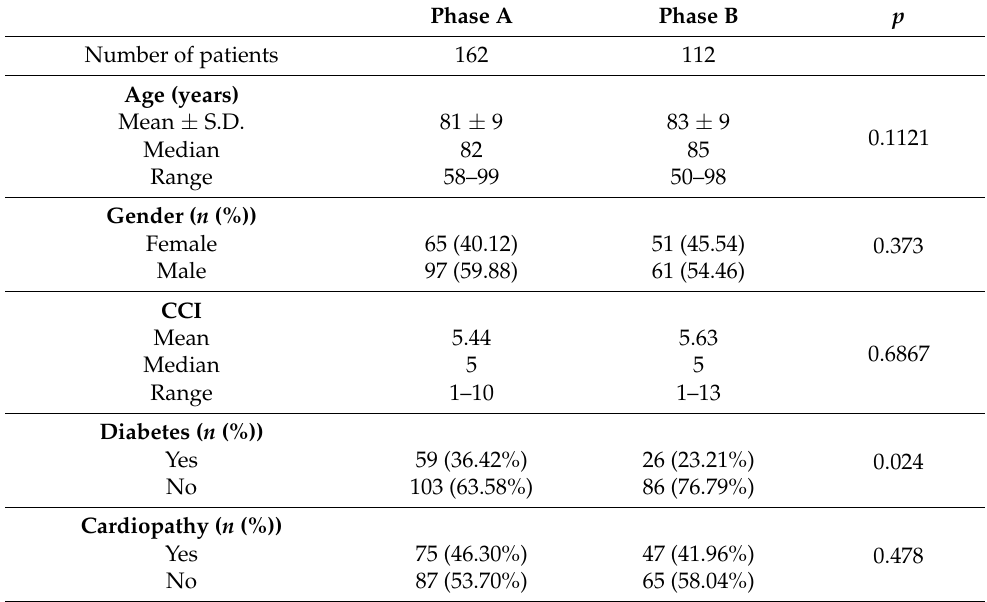
Table 1. Demographic data and comorbidities of patients who died due to SARS-CoV-2